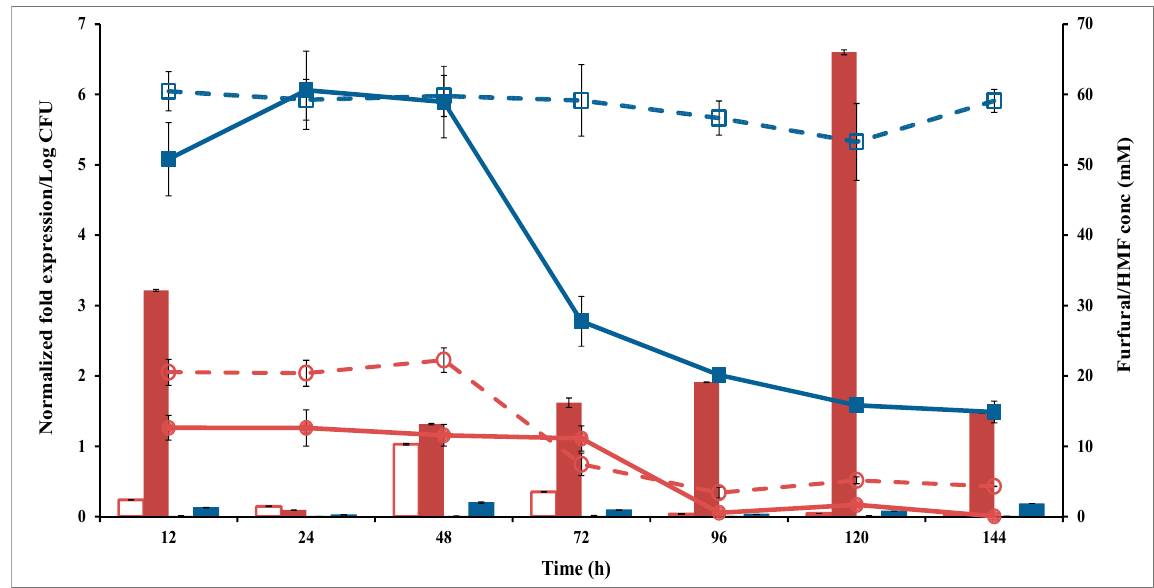
Figure 7. Ari gene expression (bar chart) and aldehyde degradation (line chart) of SCA (filled symbol) and SC (open symbol) in the presence of 60 mM HMF (Blue color) or 20 mM Furfural (Red color) on the YPD medium. SC ( S. cerevisiae ) and SCA ( S. cerevisiae with ari1 gene overexpression).